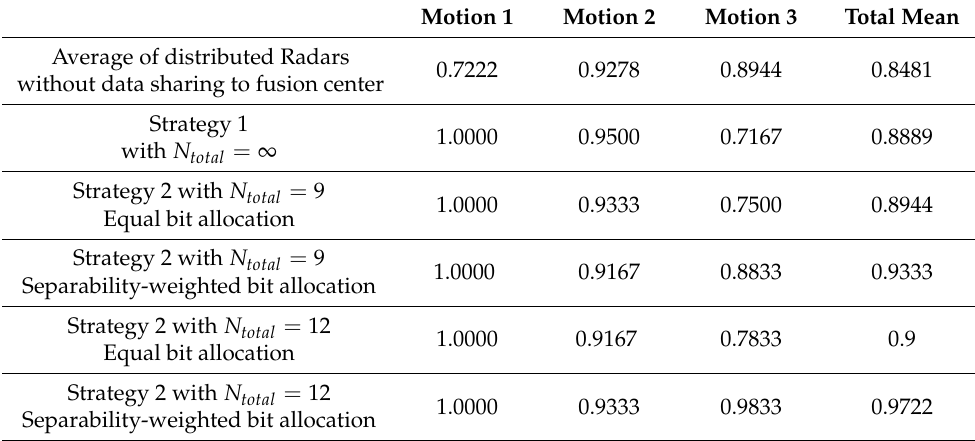
Table 1. Classification rates for the experiment settings in Figure